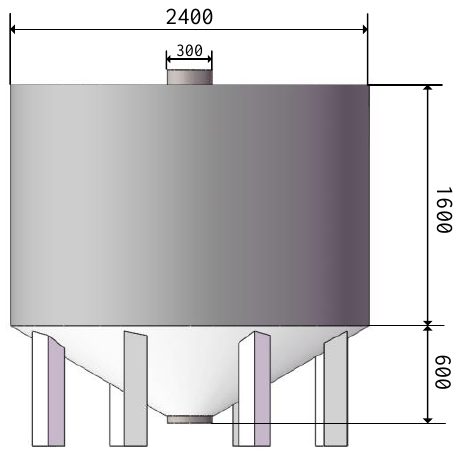
Figure 2. Engineering and geology overview: ( a ) construction site map; ( b ) stratigraphic map.